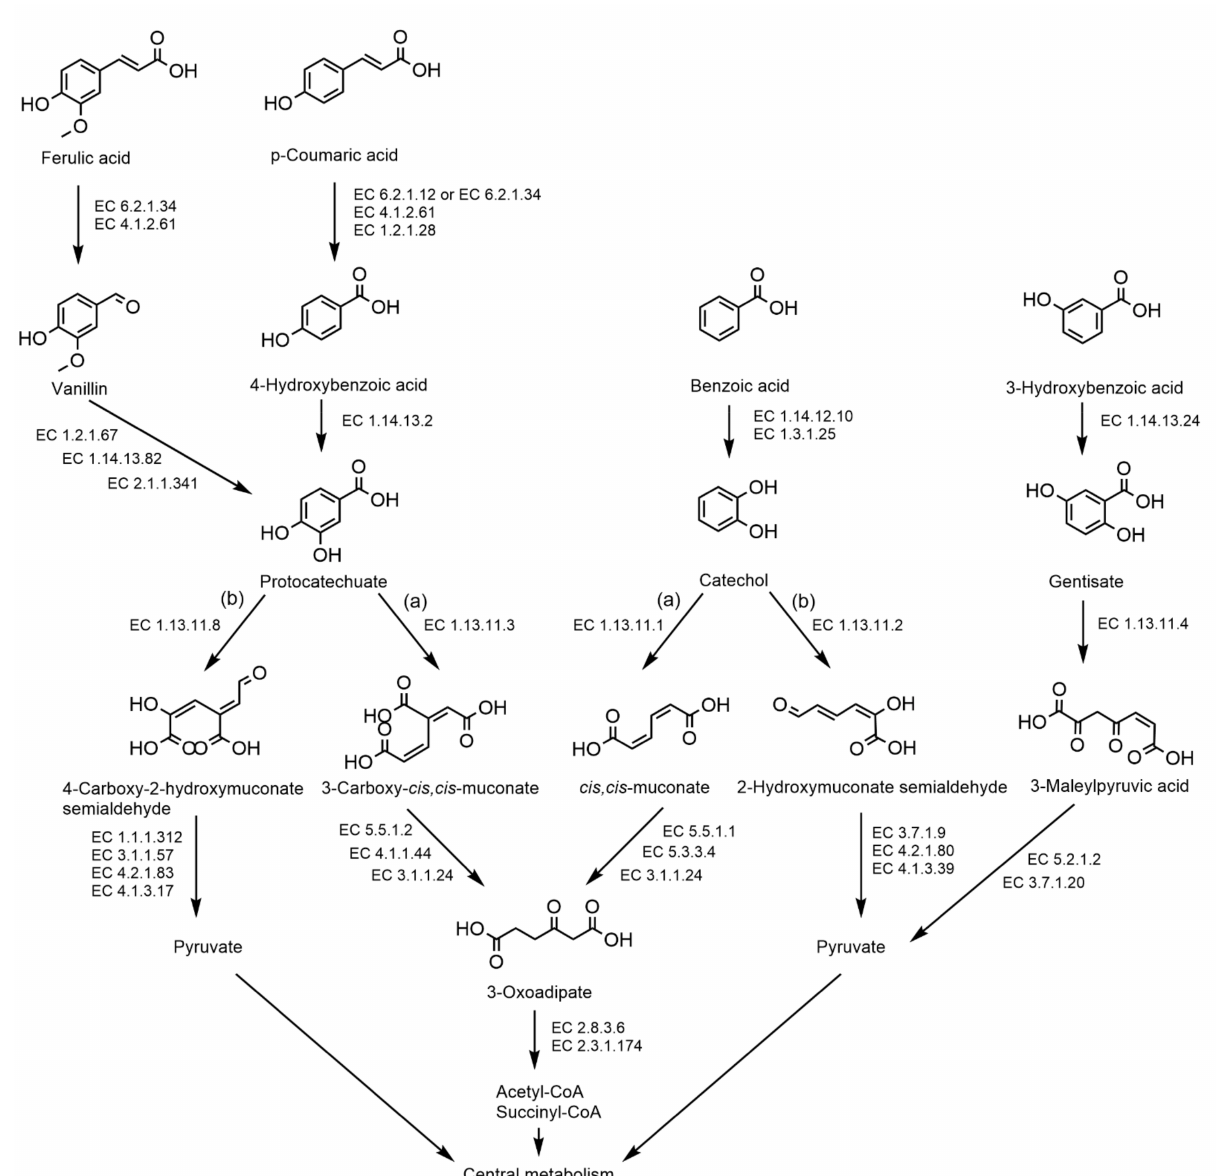
Figure 3. Degradation pathways of benzoic acid, 3-hydroxybenzoic acid and the lignin derived compounds ferulic acid and p-coumaric acid. ( a ) Ortho-cleavage pathway; ( b ) meta-cleavage pathway. Chemical structures were drawn with ChemDraw